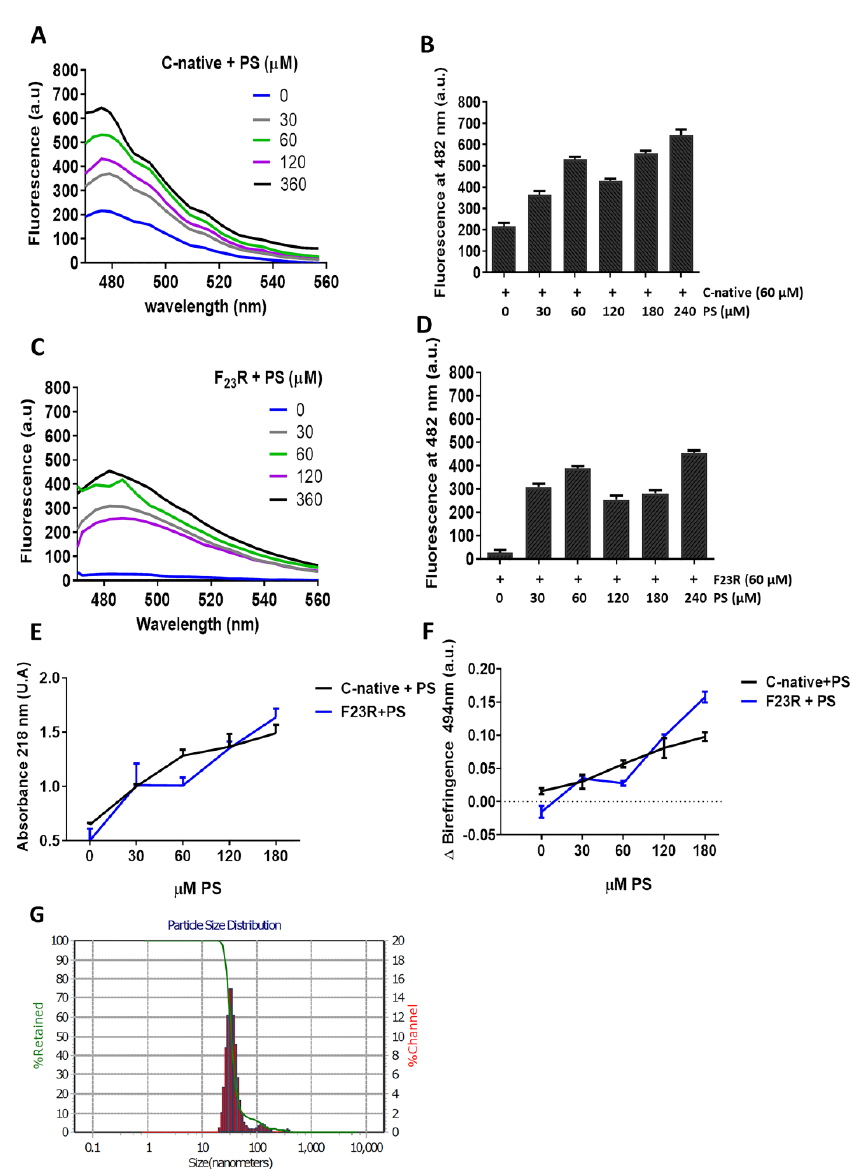
Figure 5. PS-SUVs promote the formation of β -sheet structures on the C-terminal-derived peptides of IAPP. ( A ) Interaction of the C-native segment at increasing concentrations of PS evaluated by ThT-fluorescence assays. ( B ) Same experimentation as in A, ThT-fluorescence at 482 nm. ( C ) Fluorescence emission spectra obtained through ThT assays on the F 23 R variant under increasing concentrations of PS. ( D ) Same experimentation as in ( C ), ThT-fluorescence at 482 nm. ( E ) Evaluation of the PS-effect on the secondary structure of peptides through peptide-bond absorbance at 218 nm, and by Congo red birefringence at 494 nm ( F ). ( G ) Dispersion of the size of PS-SUVs used in this experimentation by DLS.